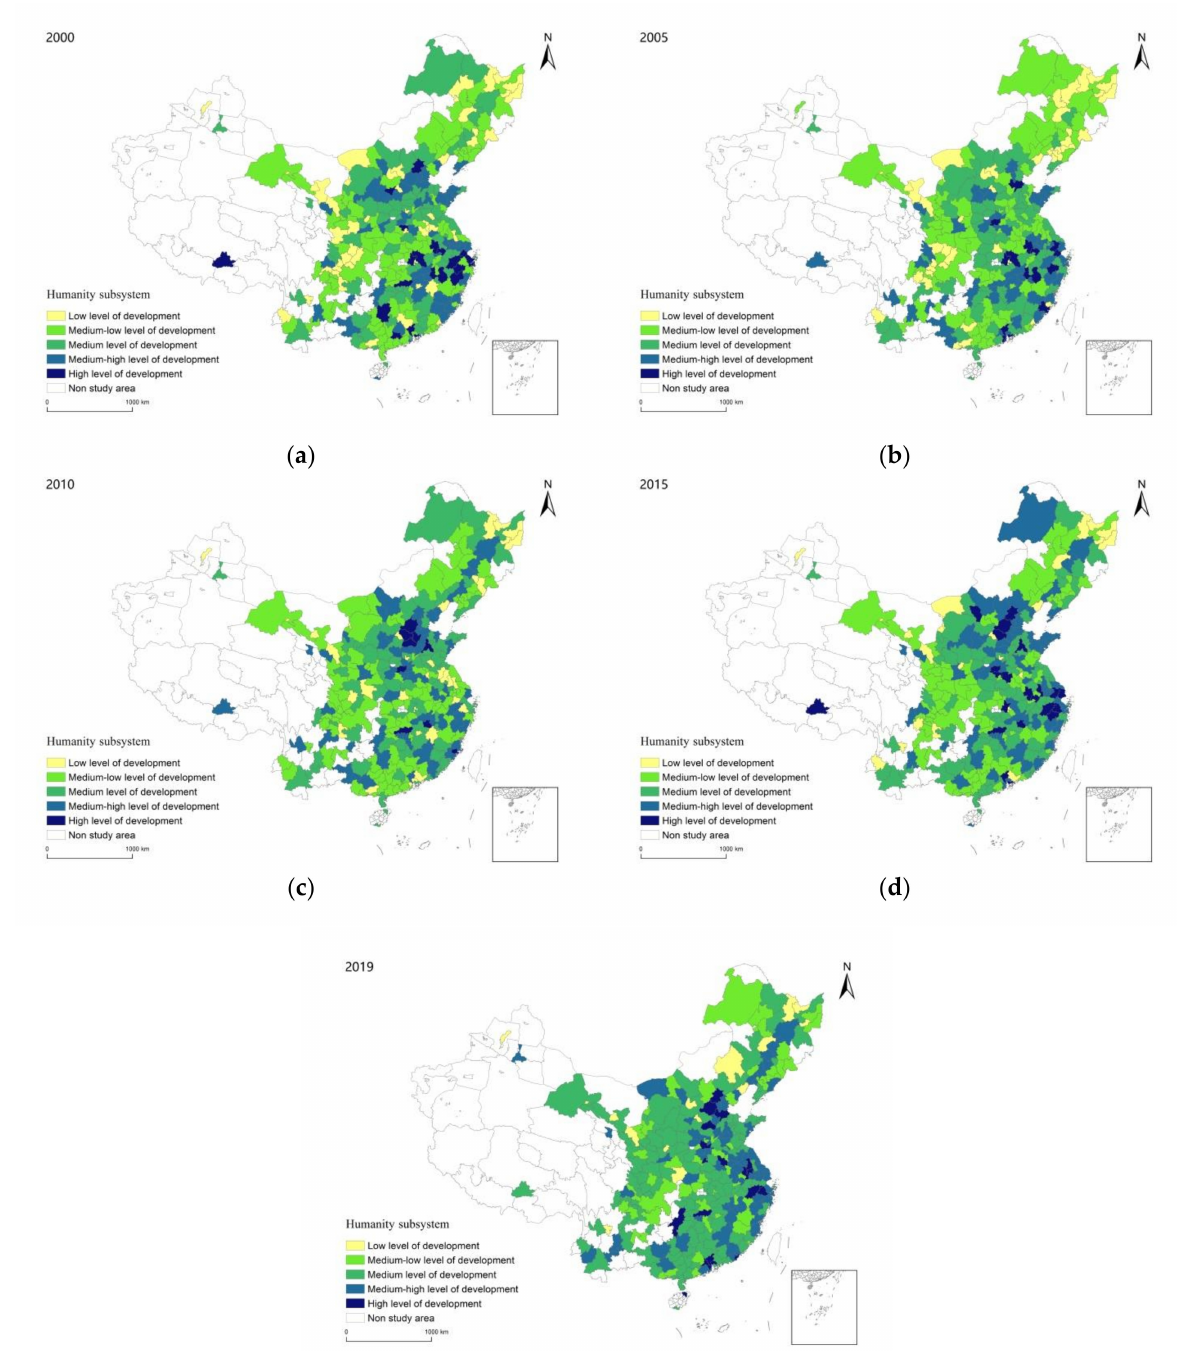
Figure 3. Spatial distribution map of the sustainable development level of the humanity system of urban human settlements in China. ( a ) 2000; ( b ) 2005; ( c ) 2010; ( d ) 2015; and ( e )